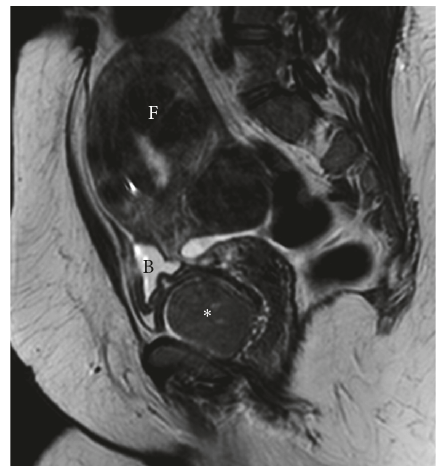
Figure 1: Preoperative imaging: T2-weighted pelvic MRI. F: fibroid uterus. B: bladder. ∗ Paraurethral leiomyoma.